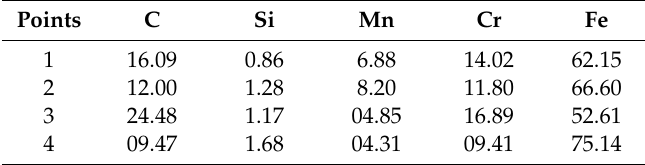
Figure 5. Microstructure of the cross-section of the two cladding layers: ( a ) The top zone of the over-lapped cladding layer; ( b ) The heat-affected zone and the substrate of the over-lapped cladding layer; ( c ) The top zone of the dot-shaped cladding layer; ( d ) The heat-affected zone and the substrate of the dot-shaped cladding layer. Table 3. EDS analysis of the four points in Figure 5